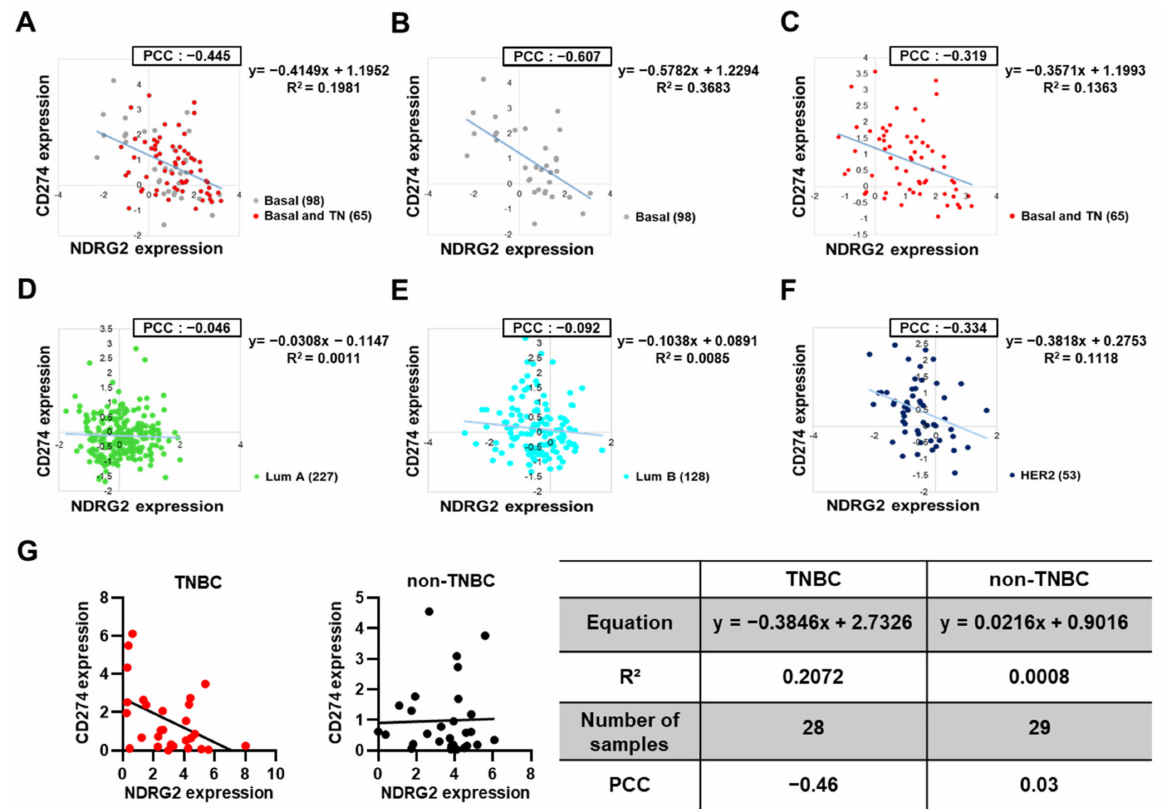
Figure 6. Negative correlation of NDRG2 and PD-L1 expression in human breast cancer patients. ( A – F ) Scatter plot showing a negative correlation between NDRG2 and PD-L1 expression in breast cancer patients from the TCGA dataset analysis. Pearson correlation coefficient (PCC) values between two genes and the related trendlines are depicted with equations. ( G ) Linear regression analysis of NDRG2 and PD-L1 expression levels in TNBC or non-TNBC cell lines. Number of samples, trendline equations, R 2 (coefficient of determination), and PCC values are shown in a separate